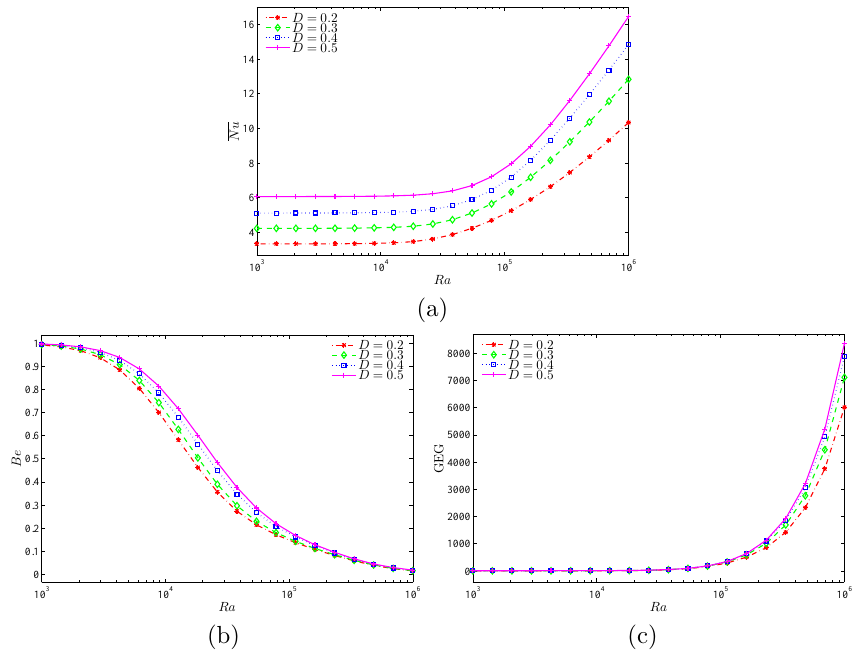
Figure 17. Evaluation of ( a ) average Nusselt number ( Nu ), ( b ) Bejan number ( Be ), and ( c ) the global entropy generation (GEG) with Ra and different D for hybrid nanofluids and φ =